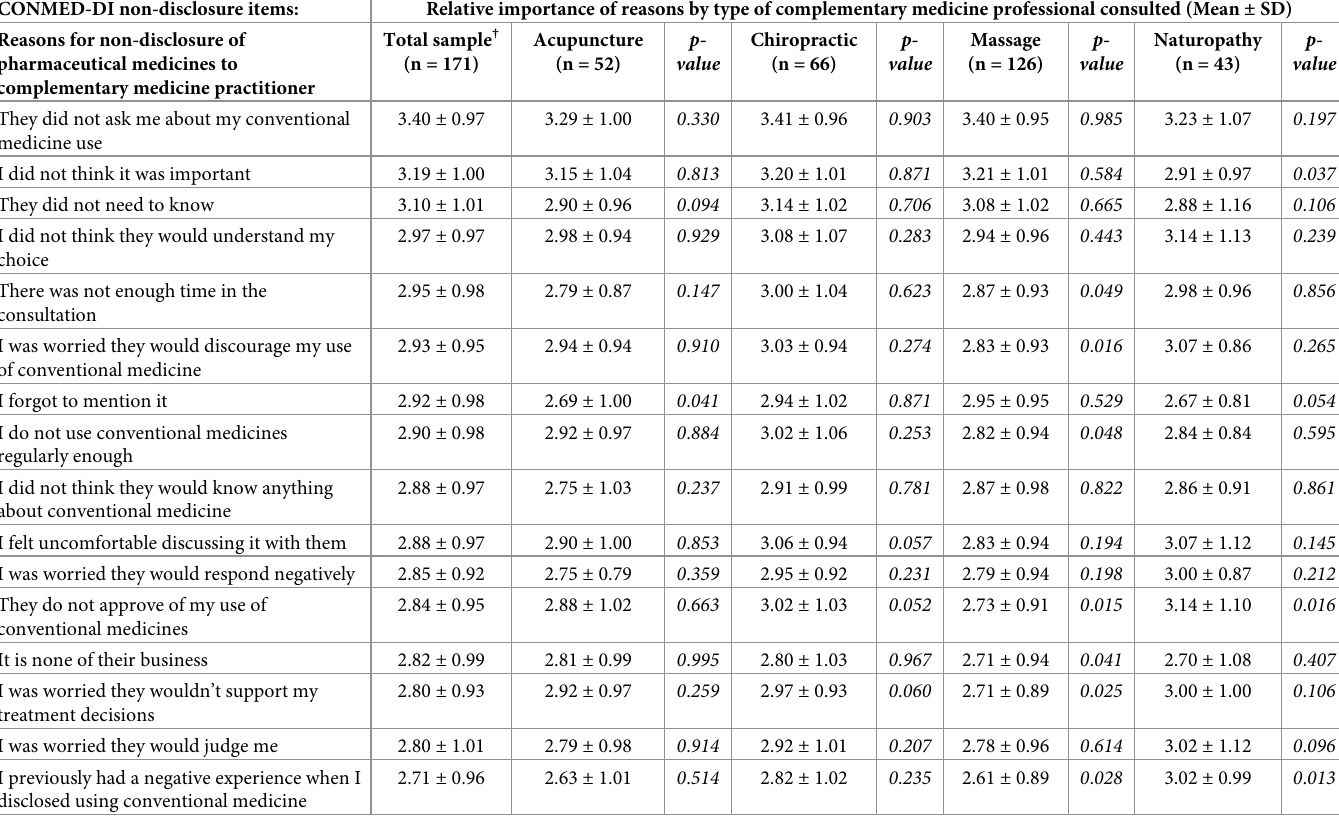
Table 6. T-test showing differences in reasons for non-disclosure of conventional medicine use to medical doctors for each type of complementary medicine profes- sional